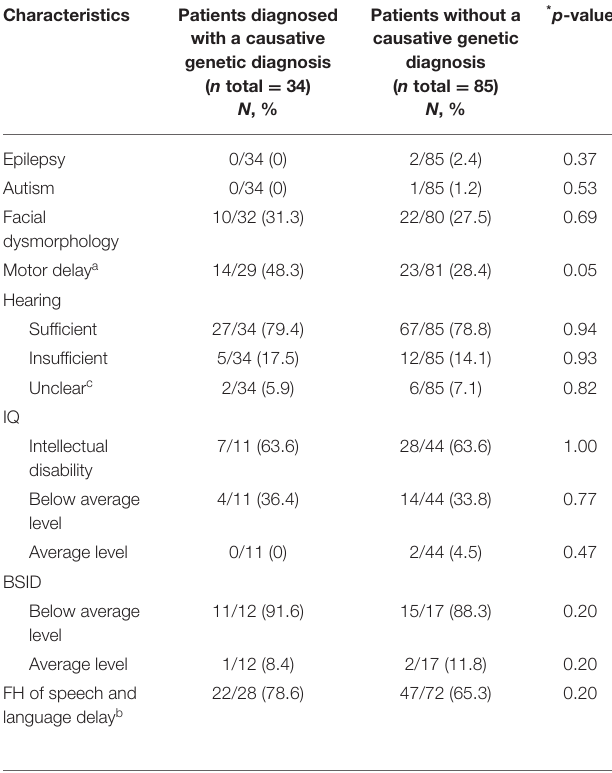
TABLE 3 | Comparison in characteristics between children who underwent genetic testing and were diagnosed with a causative genetic diagnosis vs. children without a causative genetic